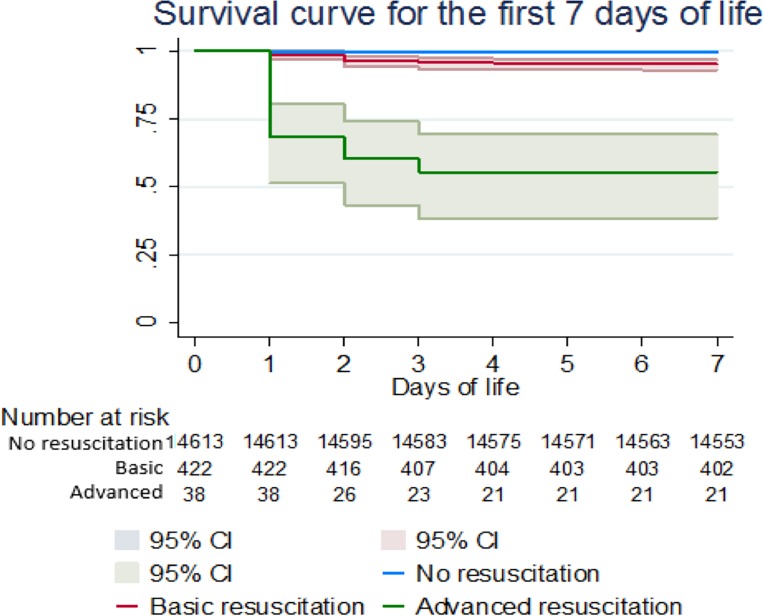
Kaplan Meier survival curve for early mortality according to the need for resuscitation.